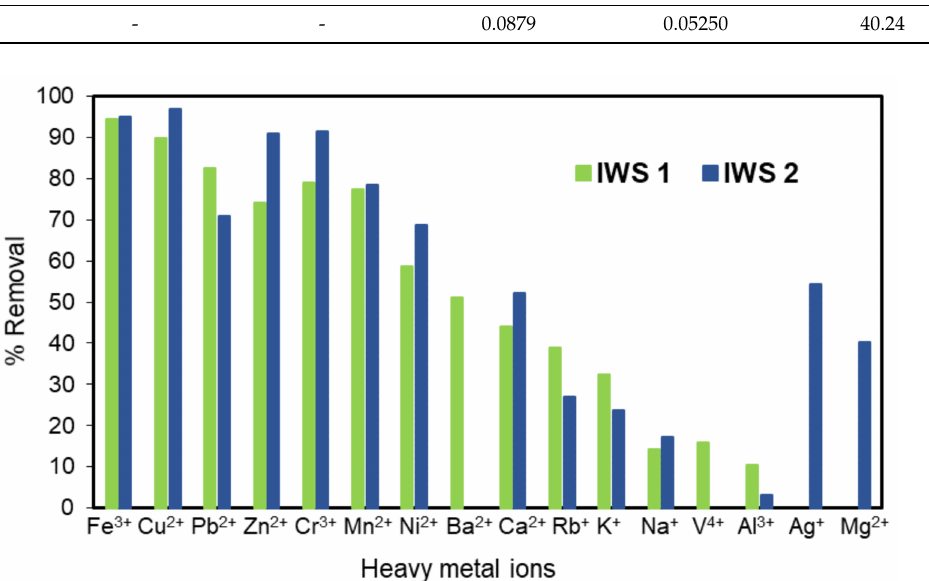
Figure 10. Removal of metal ions in industrial wastewater (IWS1 and IWS12) by